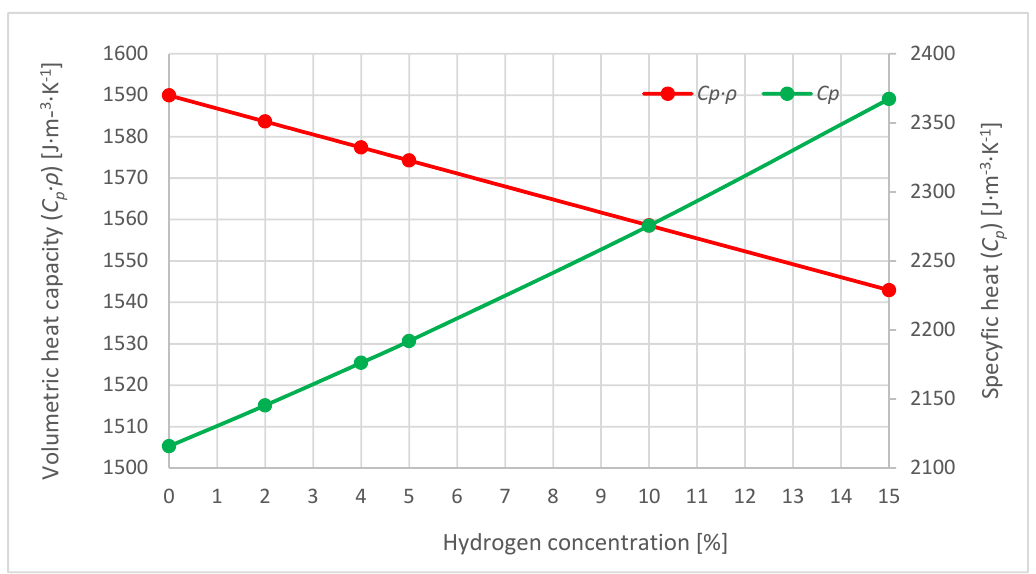
Figure 12. Specific heat ( C p ) and volumetric heat capacity (product of C p · ρ ) of used gas mixtures.